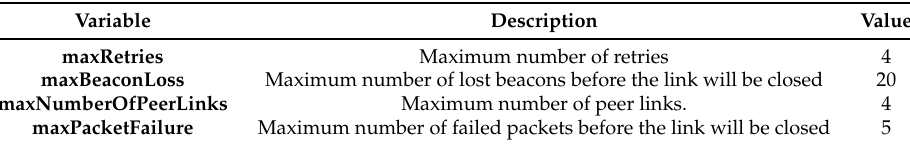
Table 5. Mesh Peering Management (MPM) protocol parameters.